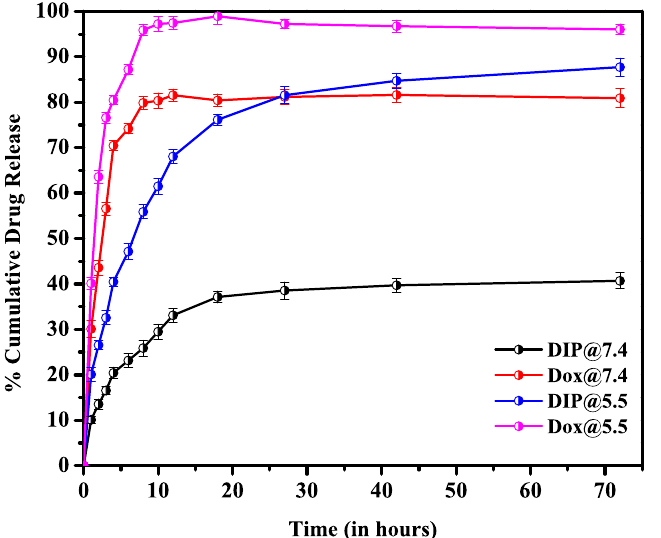
Figure 13. Percentage drug release of Doxorubicin hydrochloride and DIP proniosomal gel-derived niosomes [Origin(Pro) 8.5].